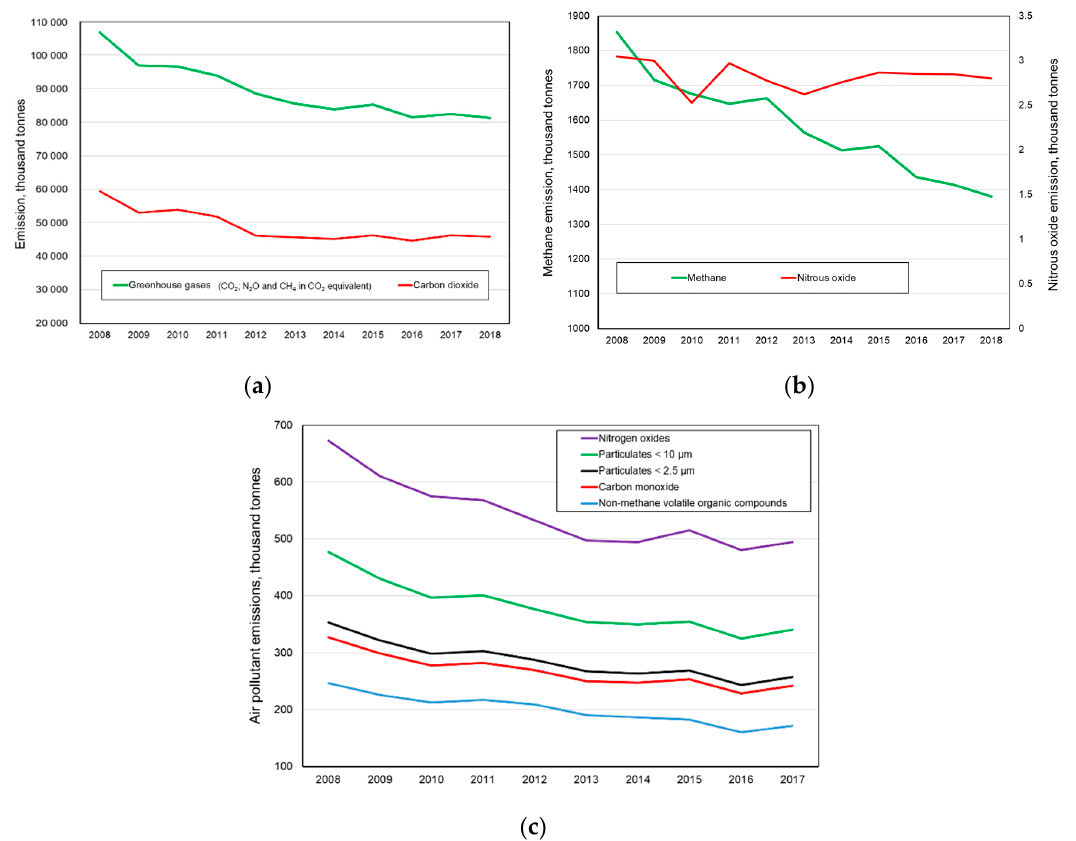
Figure 2. Greenhouse gas ( a , b ) and air pollutant ( c ) emissions from the mining and quarrying sector between 2008–2017 in European Union (EU) countries (own elaboration based on data from [45]).